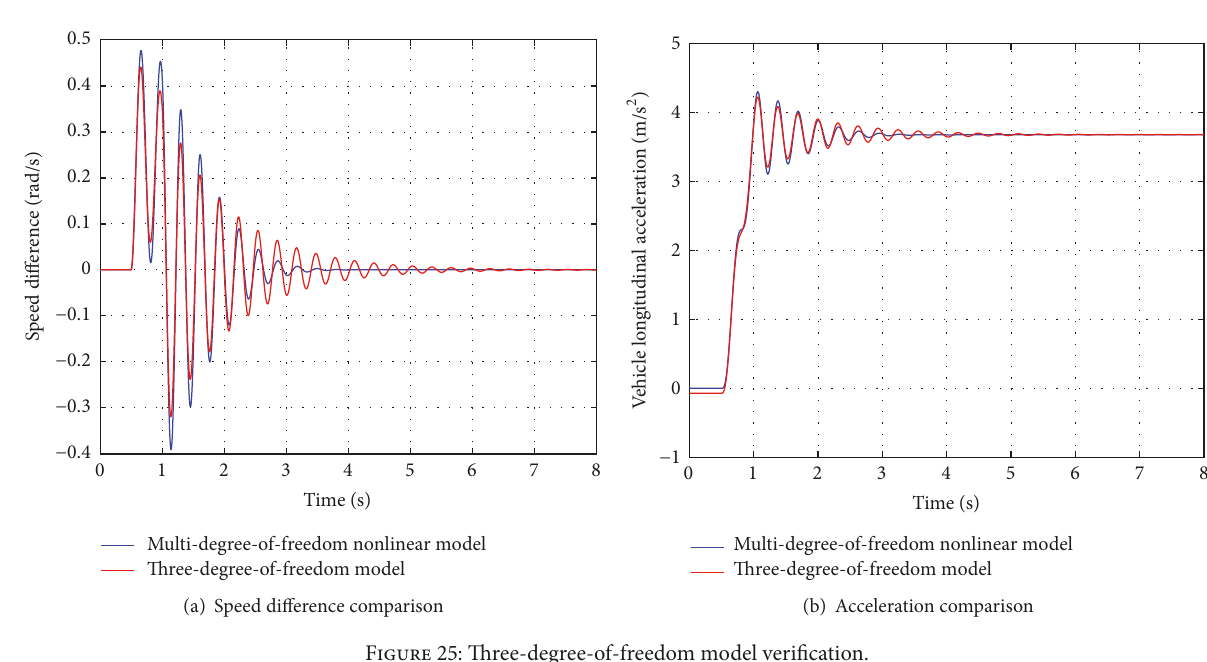
Figure 25: Three-degree-of-freedom model verification.